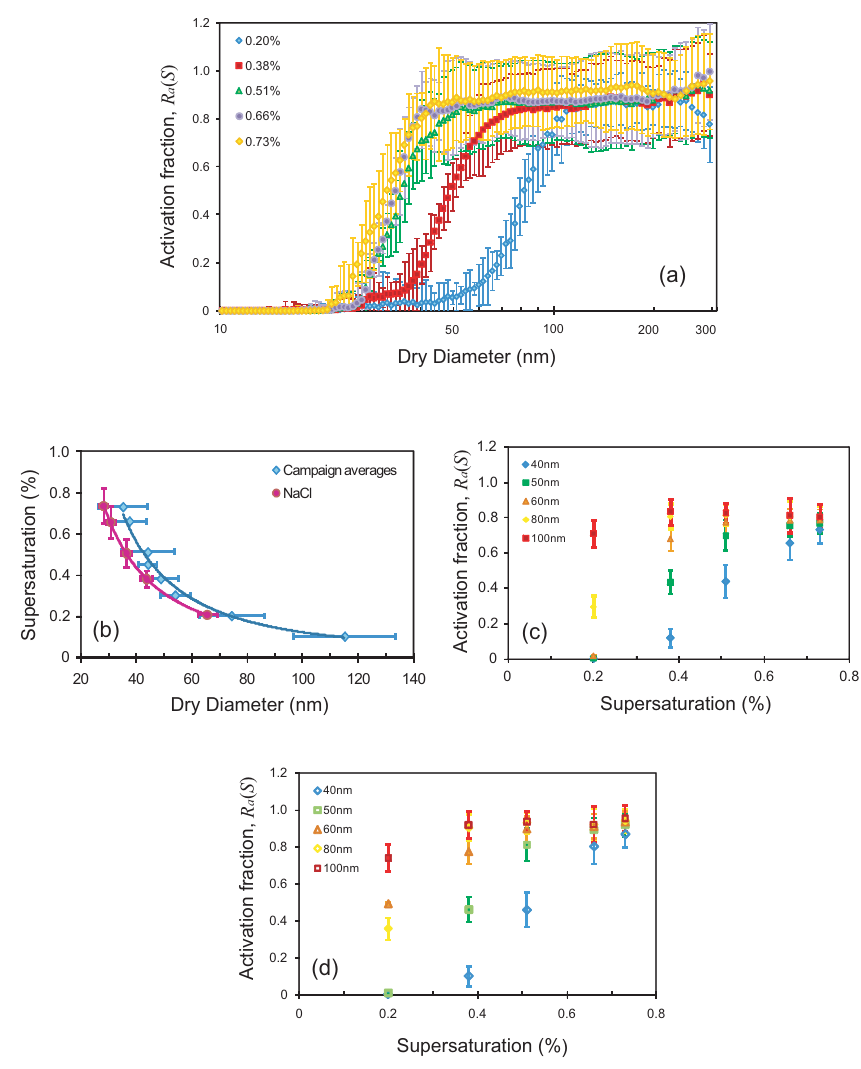
Fig. 6. (a) Averaged size-resolved CCN efficiency spectra at different levels of supersaturation (0.2–0.73%): activated particle fraction plotted against particle dry diameter, (b) CCN activation spectrum ( S c vs. d p50 ) for the whole measurement period, (c) R a (S) for 14 July, and, (d) R a (S) for 24 July.